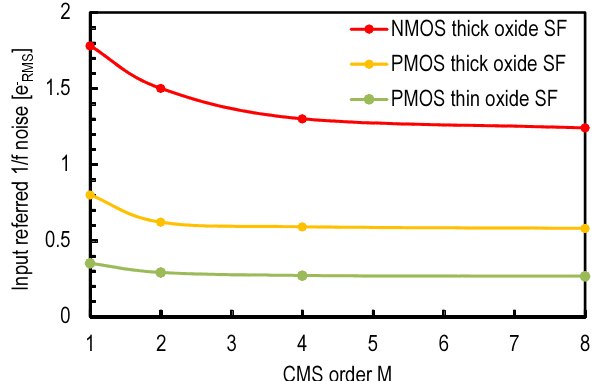
Figure 9. Input-referred 1/ f noise of a CIS readout chain, with 4T pixel, column amplification and CMS [17], obtained with transient noise simulations, as a function of the CMS order M for different in-pixel source follower transistor types. The pixels with thick oxide NMOS and PMOS SFs feature a conversion gain of about 85 µ V/ e − , while the thin oxide SF based pixel features a conversion gain of 185 µ V/ e −